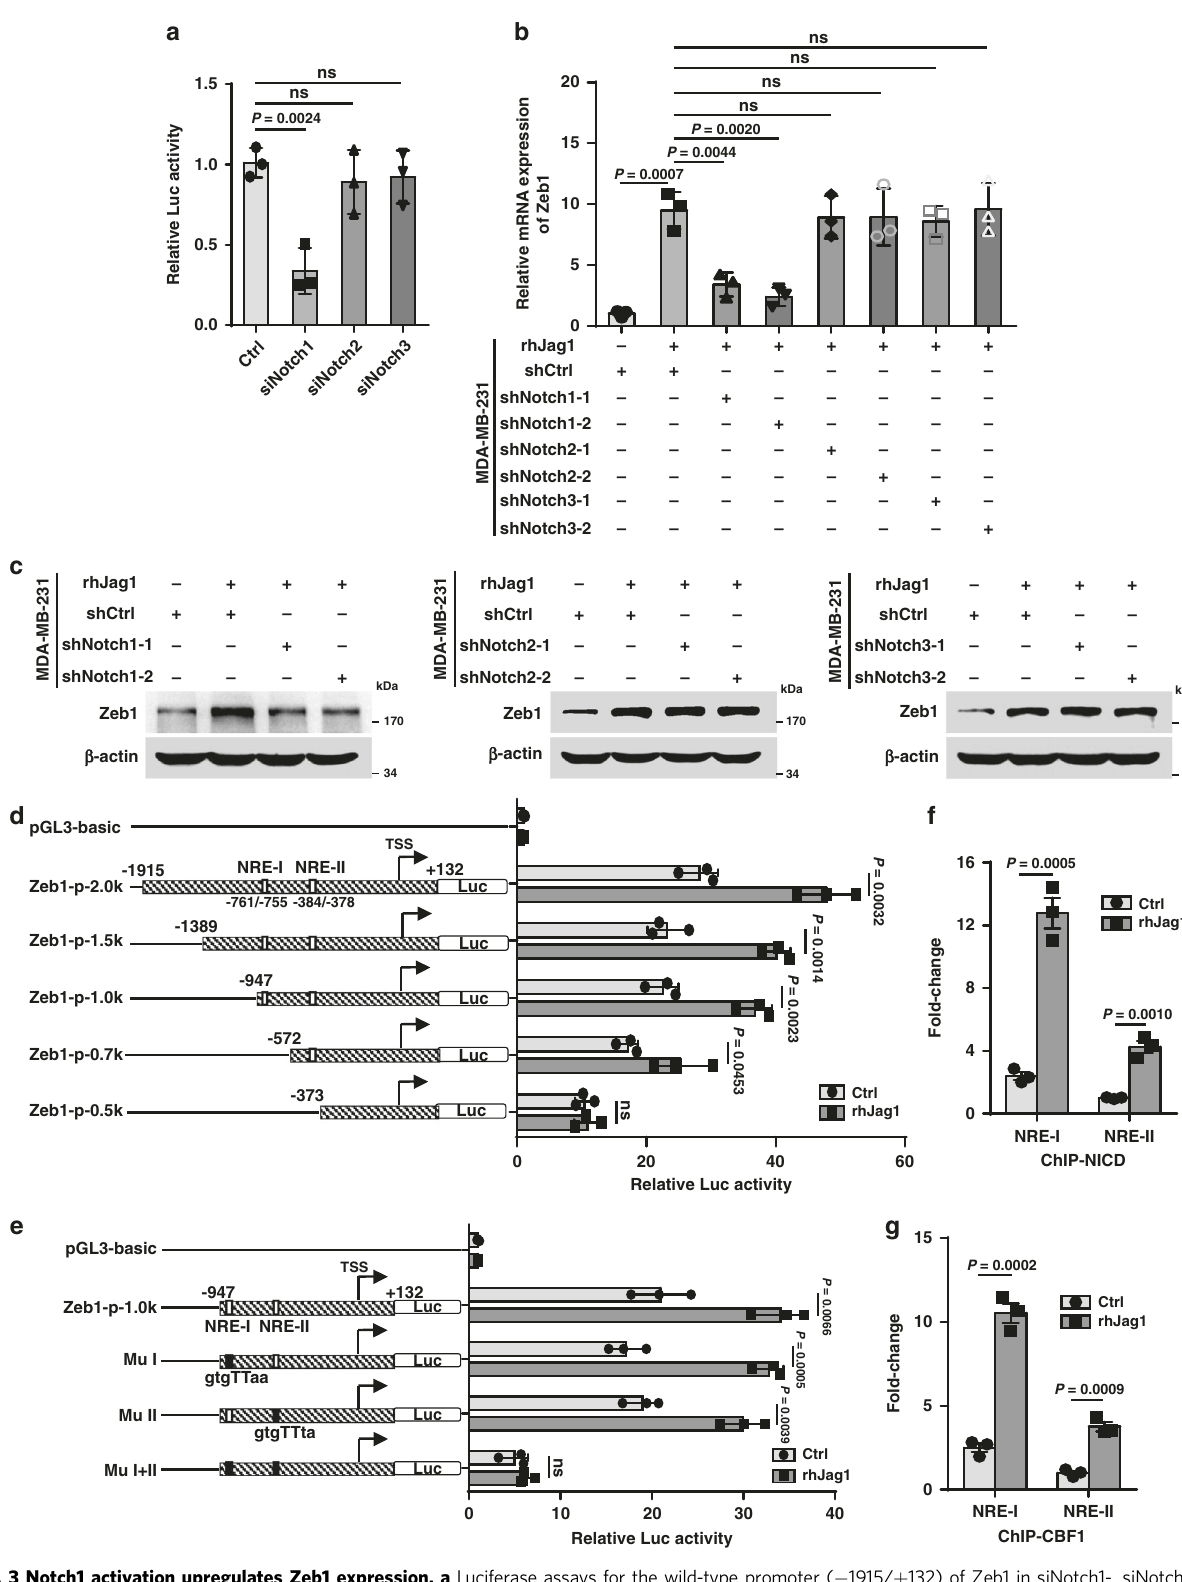
Fig. 3 Notch1 activation upregulates Zeb1 expression. a Luciferase assays for the wild-type promoter ( − 1915/ + 132) of Zeb1 in siNotch1-, siNotch2- or siNotch3-transfected MDA-MB-231 cells. b Relative mRNA levels of Zeb1 in shNotch1-, shNotch2- or shNotch3-transfected MDA-MB-231 cells after treatment with rhJag1. c Protein levels of Zeb1 in shNotch1-, shNotch2- or shNotch3-transfected MDA-MB-231 cells after treatment with rhJag1. d Luciferase assays for wild-type ( − 1915/ + 132) or truncated promoters of Zeb1 in MDA-MB-231 cells after treatment with rhJag1. e Luciferase assays for wild-type ( − 947/ + 132) or NRE-mutated promoters of Zeb1 in MDA-MB-231 cells after treatment with rhJag1. f , g ChIP assays for recruitment of f NICD and g CBF1 to the endogenous Zeb1 promoter in MDA-MB-231 cells after treatment with rhJag1. Indicated P -values were calculated using two-tailed unpaired Student ’ s t -test. Data are presented as mean±SEM in a , b , d – g . Data are representative of three ( a – g ) independent experiments. Source data are provided as a Source Data fi